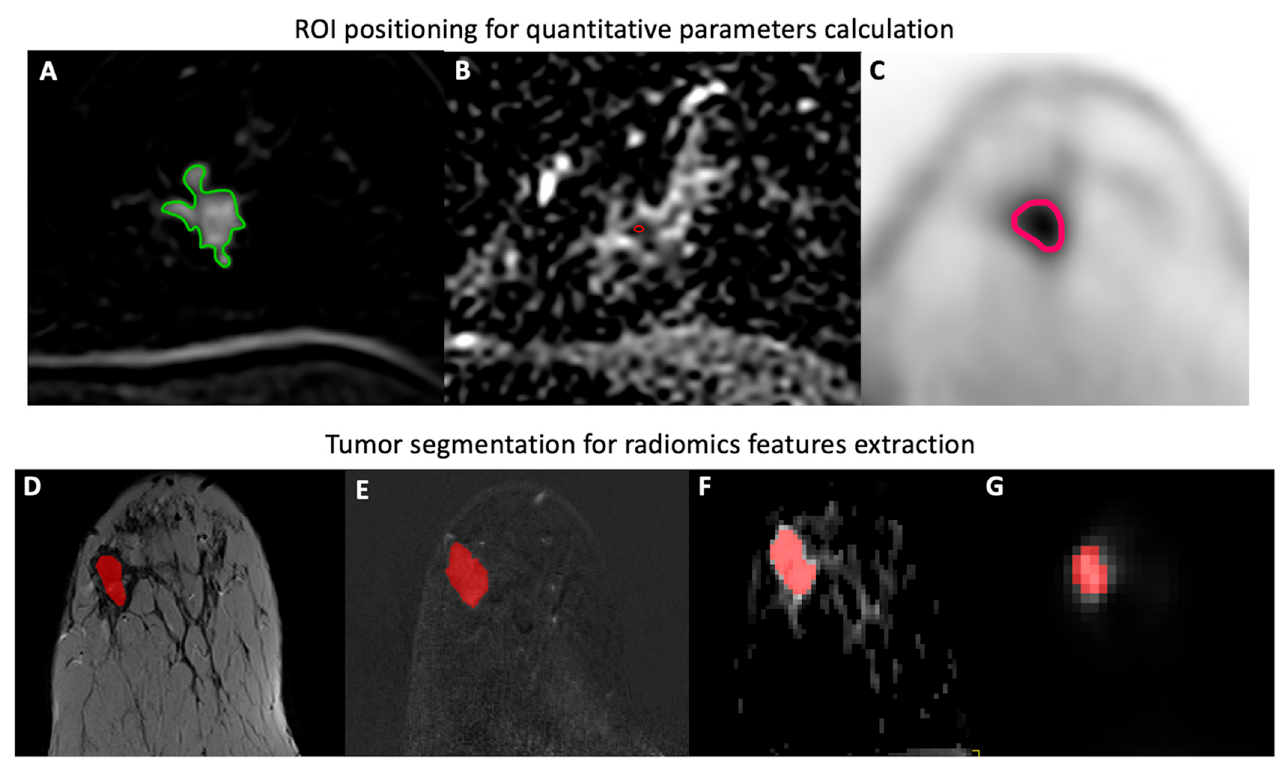
Figure 1. Examples of 2D ROI placement for the extraction of quantitative parameters (mean transit time; plasma flow; volume distribution; ADC mean; and SUVmax, mean, and minimum) ( A – C ), and whole tumor segmentation for radiomics features (first, second, and higher order) extraction ( D – G ) from primary BC tumor lesions on DCE ( A , E ), DWI ( B , F ), PET ( C , G ), and T2-weighted ( D ) images.